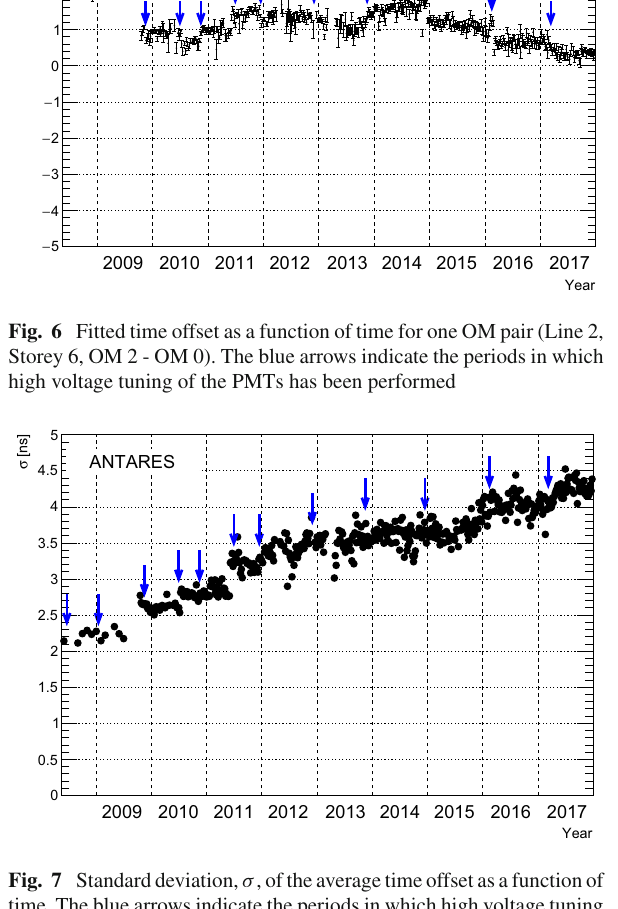
which are produced for each OM pair, serve as input for the intra-storey calibration